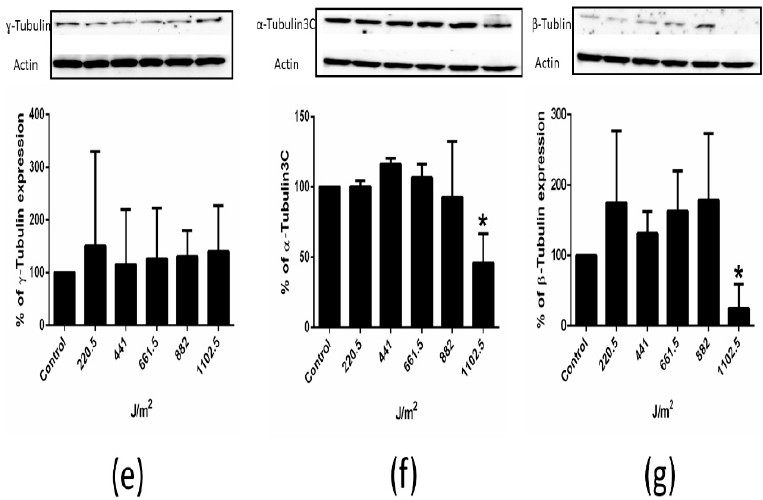
Figure 4. p53, E2F1 and microtubules system proteins are regulated in SiHa cells treated with UVB. SiHa cells were treated with increasing doses of UVB for 72 h and the expression of p53, E2F1 and proteins of microtubule system (MAP1S, MAP2, γ -Tubulin, β -Tubulin, α -Tubulin3C) were analyzed by Western blotting. ( a ) The protein expression of p53 was analyzed. Five independent experiments were analyzed by Kruskal–Wallis test in the bottom graphic (1102.5 J/m 2 * p < 0.0332). ( b ) The protein expression of E2F1 was analyzed. Five independent experiments were analyzed by Kruskal–Wallis test (661.5 J/m 2 * p < 0.0374), 882 J/m 2 *( p < 0.0473) and 1102.5 J/m 2 ** ( p < 0.0031). ( c ) The protein expression of MAP1S was analyzed. Five independent experiments were analyzed by Kruskal–Wallis test (1102.5 J/m 2 * p < 0.0094). ( d ) The expression of MAP2 was analyzed. Three independent experiments were analyzed by correlation test ( r = − 0.6754 and p < 0.0021). ( e ) The protein expression of γ -Tubulin was analyzed. Three independent experiments were analyzed by correlation test ( r = − 0.7674, p < 0.0002). ( f ) The protein expression of α -Tubulin3C was analyzed. Three independent experiments were analyzed by correlation test ( r = − 0.4932, p < 0.0375). ( g ) The protein expression of β -Tubulin was analyzed. Three independent experiments were analyzed by correlation test ( r = − 0.506, p < 0.0322). The protein expression of p53, E2F1, MAP1S, MAP2, γ -Tubulin, β -Tubulin and α -Tubulin3C were analyzed comparing control cells to exposed irradiated cells. Control cells were not UVB irradiated.